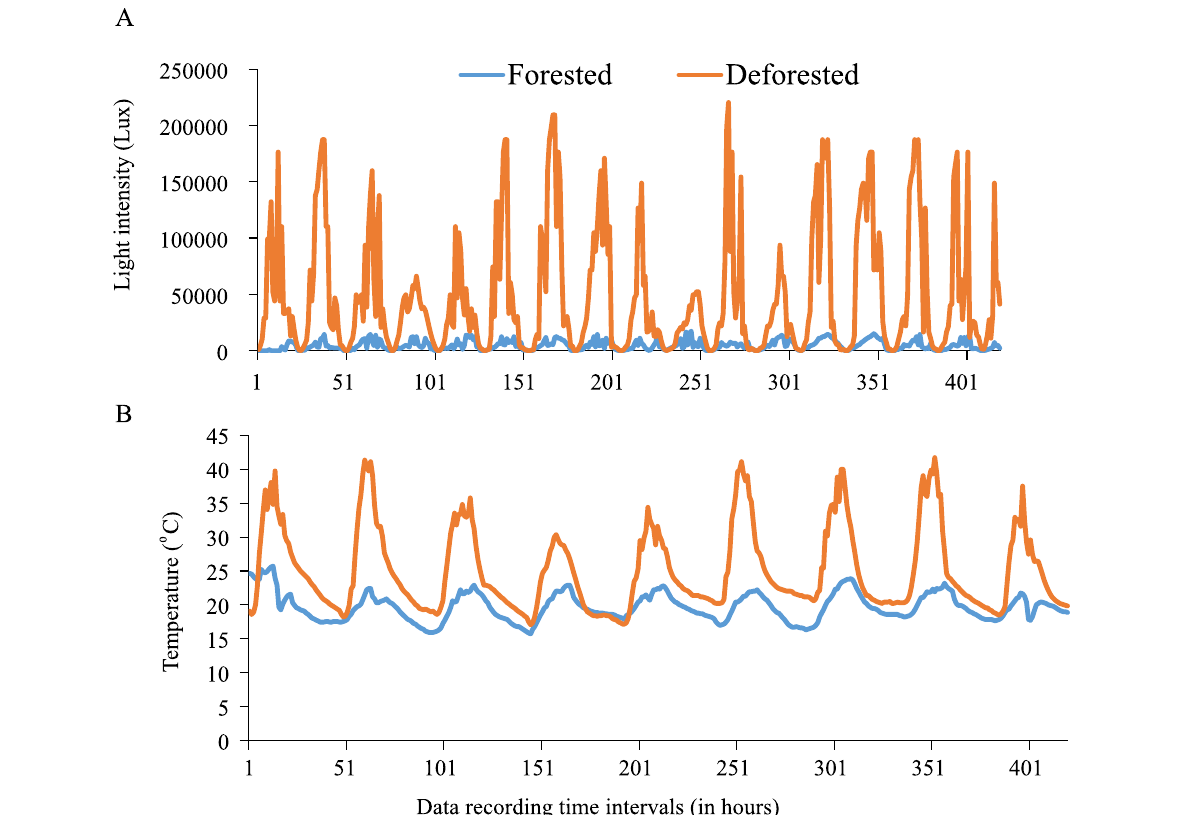
Fig. 1 The variation of A light intensity and B temperature in larvae habitats in forested and deforested